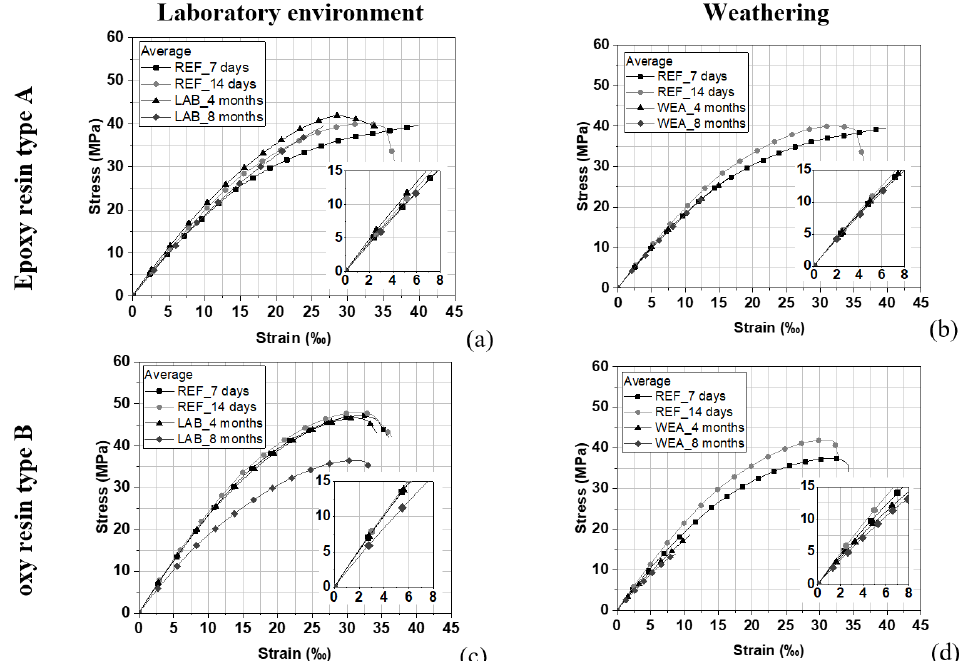
Figure 13. Stress versus strain relationship of primer (a-b) and saturation (c-d) resins maintained in a laboratory environment or exposed to